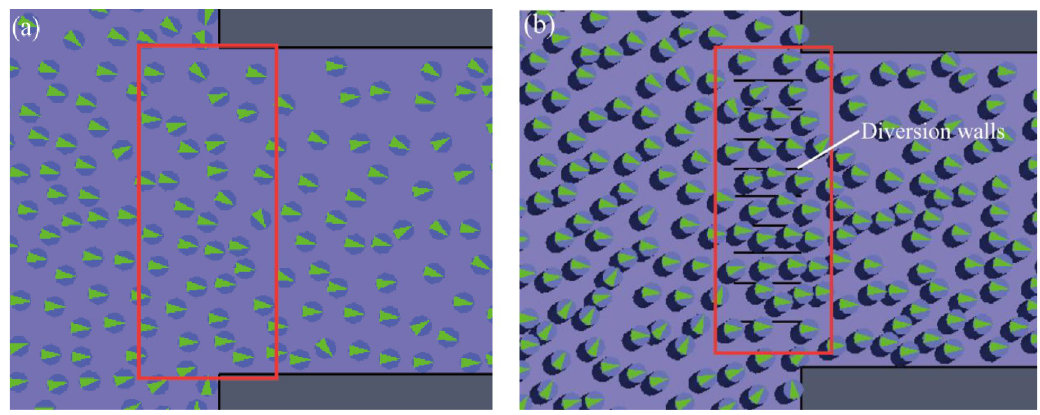
Fig 10. Effects of diversion walls on evacuation effectiveness (a) without diversion walls (basic evacuation simulation model) (b) with diversion walls (optimized evacuation simulation model).